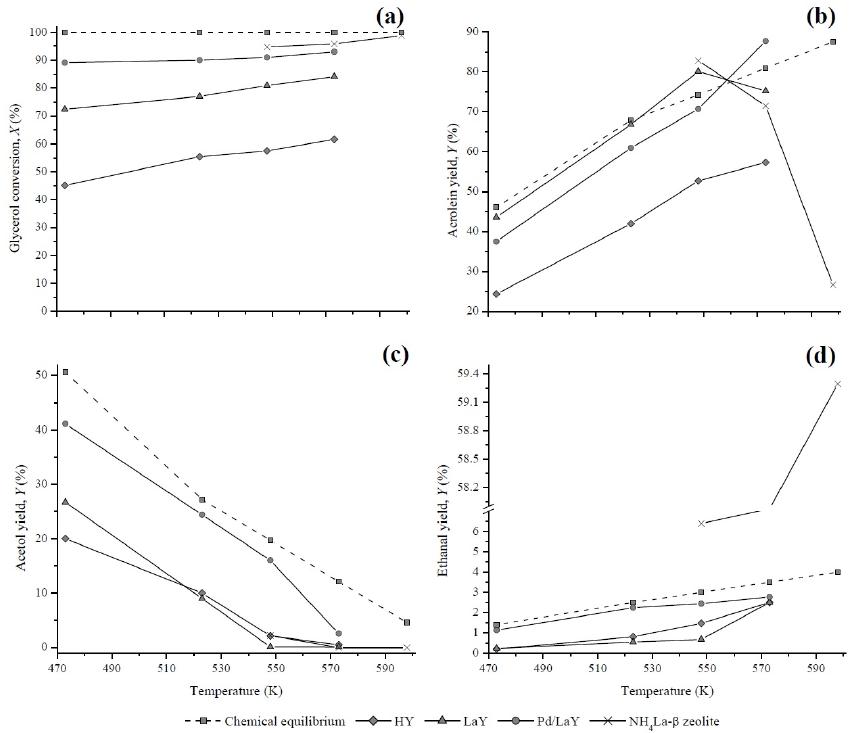
Figure 14. Comparison of estimated and experimental ( a ) glycerol conversion and yields of ( b ) acrolein, ( c ) acetol, and ( d ) ethanal of the HY, LaY, Pd/LaY, and NH 4 La- β zeolites [38].